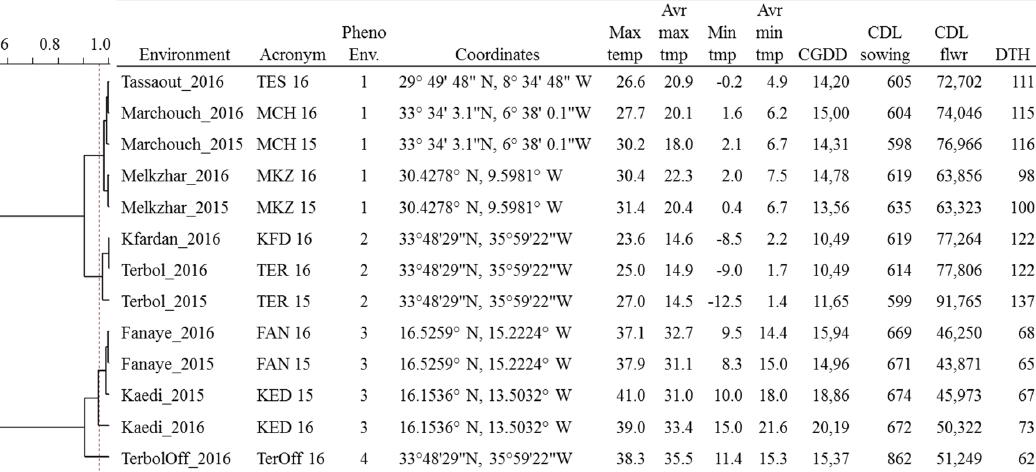
Figure 2. Meteorological parameters and phenological recordings for 13 environments including four countries—Morocco (Marchouche, Melk Zhar, and Tassaout), Lebanon (Terbol, Terbol off-season, and Kfardan), Senegal (Fanaye), and Mauritania (Kaedi)—used for the phenotyping of 384 durum wheat entries. The cladogram shows the relatedness of the environments based on PCA analysis of climatic data. Max temp: maximum temperature; Avr max temp: average maximum temperature; Min temp: minimum temperature; Avr Min Temp: average minimum temperature; CGDD: average cumulative growing degree days for flowering; CDL sowing: cumulative day length at the time of sowing; flwr: to flowering; DTH: average days to heading.